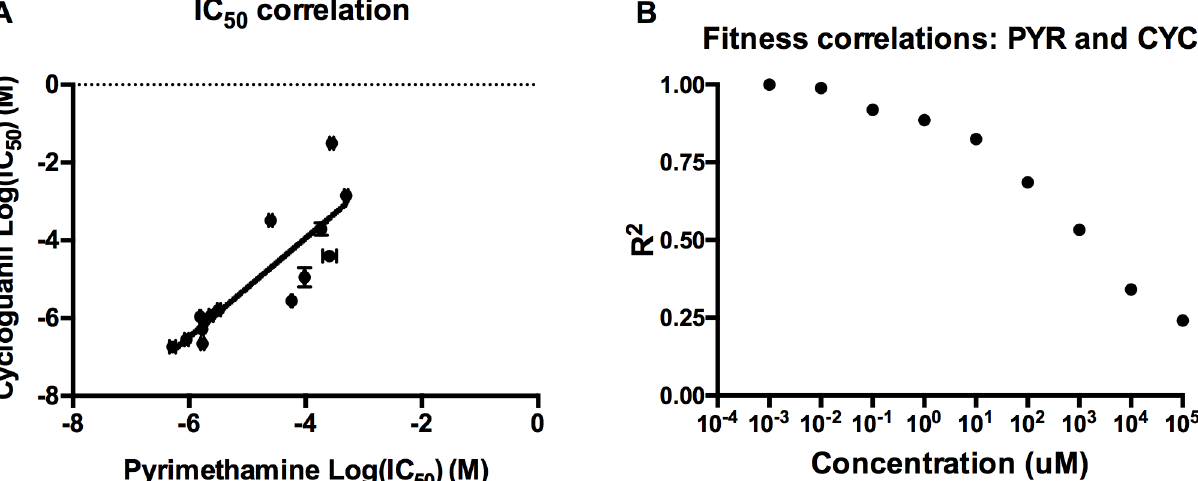
Fig 2. Resistance to pyrimethamine is correlated with resistance to cycloguanil. (A) Correlations between the IC 50 values for pyrimethamine ( y -axis) and cylcoguanil ( x -axis). Each point corresponds to a single genotype in the landscape. The landscapes are significantly correlated for both traits, indicating cross-resistance (IC 50 : R 2 = 0.74, P = 3.9 X 10 − 5 ; Error bars on IC 50 values represent standard errors of the published experimental replicates [11,12]. (B) A graph of the R 2 as a function of drug concentration, demonstrating that the landscapes remain correlated across drug concentrations, albeit less so as drug concentration increases. Pearson product-moment correlations were significant ( P < 0.05) at all concentrations except the highest in our study (1.0 X 10 5 uM), which was nearly significant ( P = 0.067). Individual scatter plots that produce these R 2 values, and corresponding P values, can be found in S1 Fig.